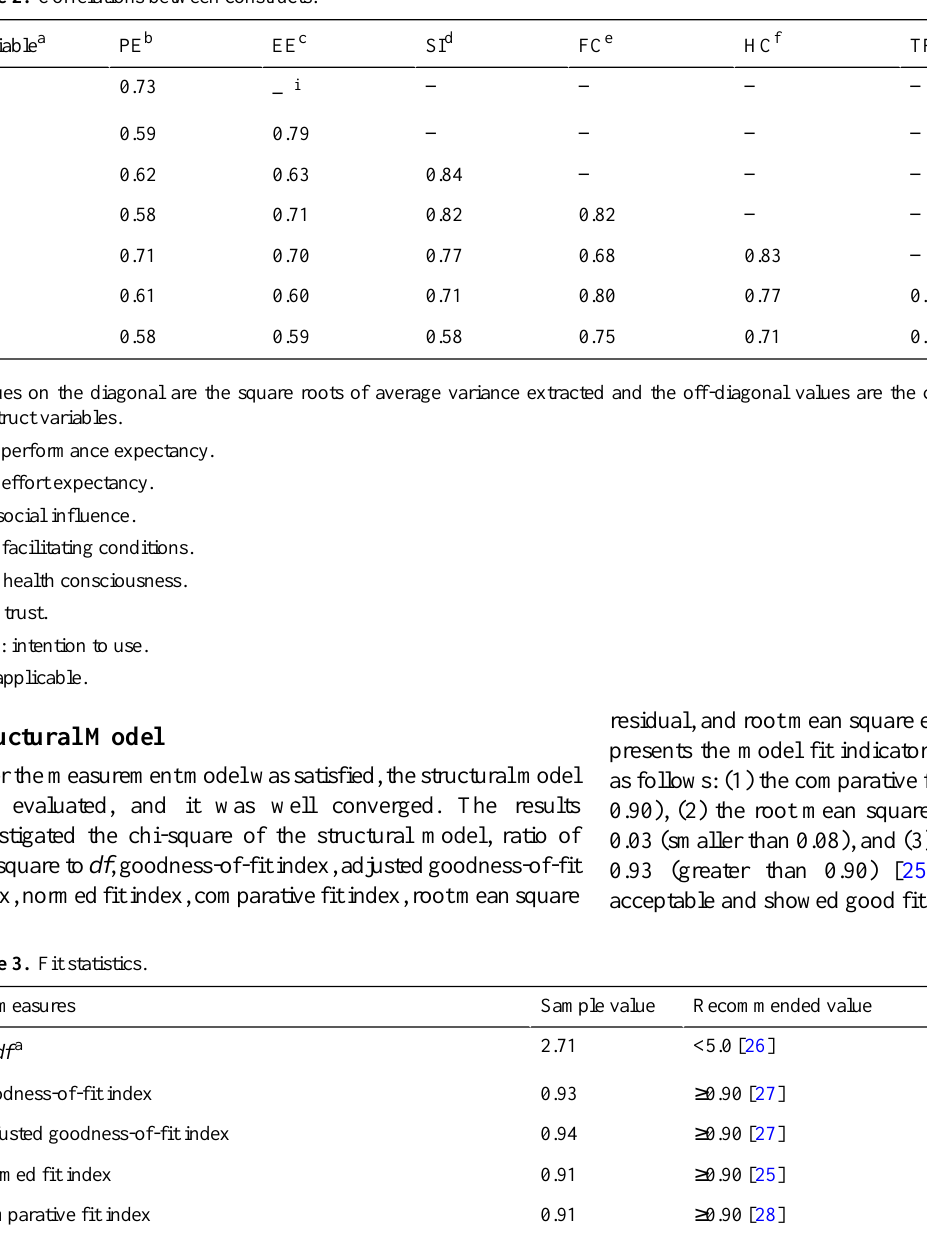
Table 2. Correlations between constructs.